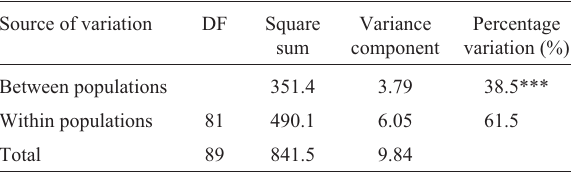
Table 4 - Analysis of molecular variance (AMOVA) among and between the Sarchimor progenies and C. arabica cultivars. Source of variation DF Square